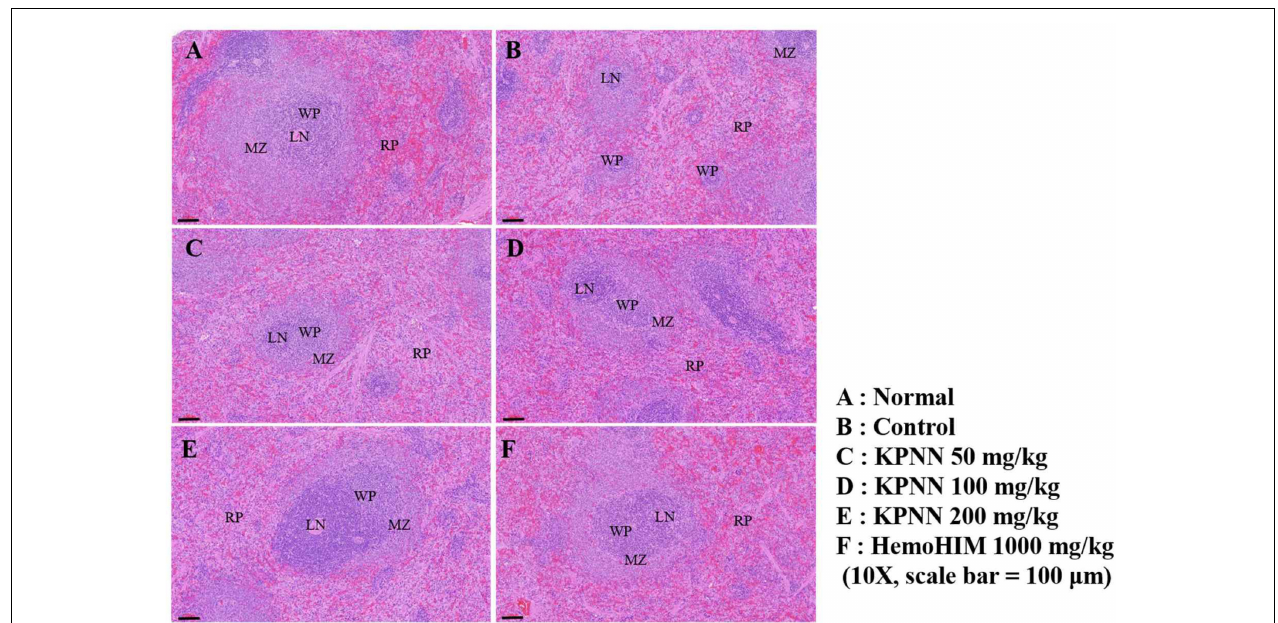
FIGURE 9 | Effects of KPNN on spleen damage in immunosuppressed rats. Wistar rats were treated with saline, cyclophosphamide (Cy; 5 mg/kg/day), oral KPNN (0, 50, 100, and 200 mg/kg/day), or oral HemoHIM (1,000 mg/kg/day) once daily for 4 weeks. Subsequently, damage to the spleen was analyzed histologically. Representative images of sectioned (A) normal (saline-treated), (B) control (only Cy-treated), and (C–E) KPNN-treated rats [treated with Cy and (C) KPNN 50 mg/kg, (D) KPNN 100 mg/kg, (E) KPNN 200 mg/kg, or (F) HemoHIM 1000 (HemoHIM 1,000 mg/kg)]. Scale bar = 100 µ m. CV, central vein; LN, lymph nodule; MZ, marginal zone; RP, red pulp; WP, white